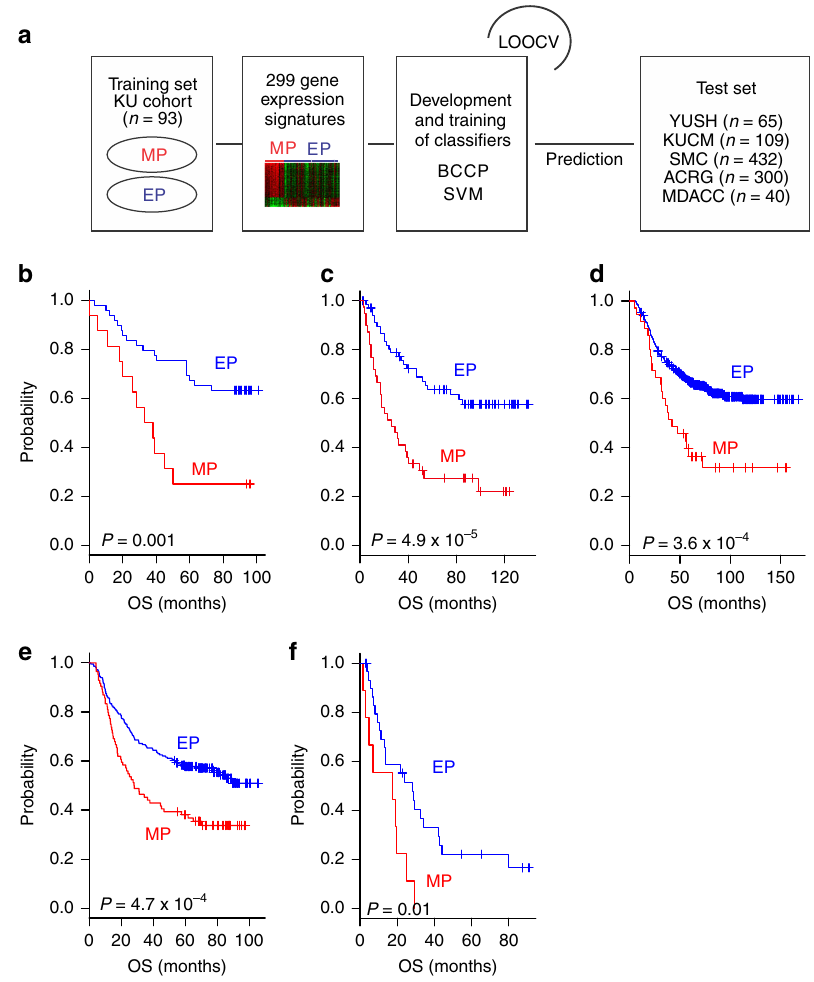
Fig. 2 Construction of prediction models in the validation cohorts. a A schematic overview of the strategy used to construct prediction models and evaluate predicted outcomes on the basis of gene expression signatures. EP epithelial phenotype, MP mesenchymal phenotype, BCCP Bayesian compound covariate predictor, SVM support vector machine, LOOCV leave-one-out cross-validation, YUSH Yonsei University Severance Hospital, KUCM Kosin